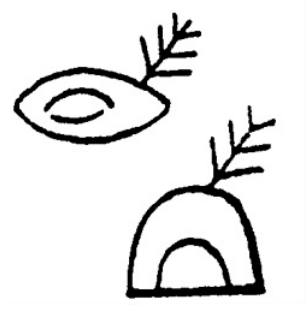
Figure 18. Archaic sign TUR 5